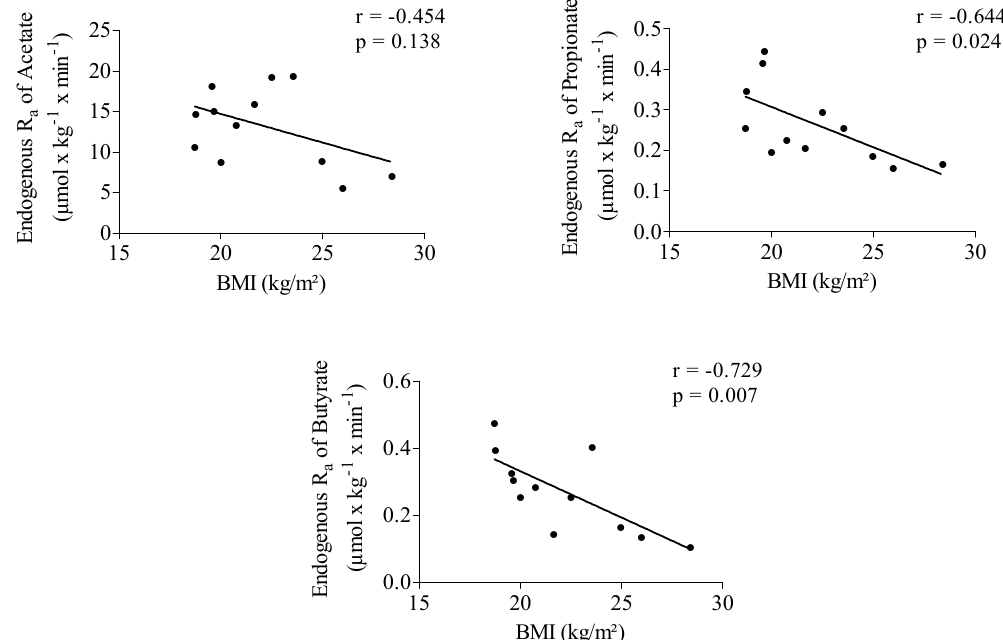
Figure 1. Correlation between acetate, propionate and butyrate endogenous rate of appearance (R a ) and body mass index (BMI). n = 12.